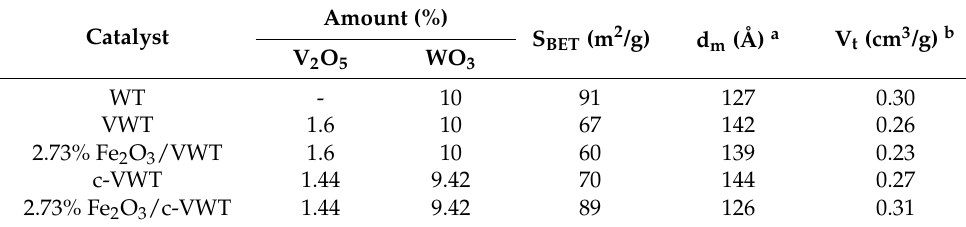
Table 1. Chemical compositions and textural properties of V 2 O 5 /TiO 2 -based catalysts.